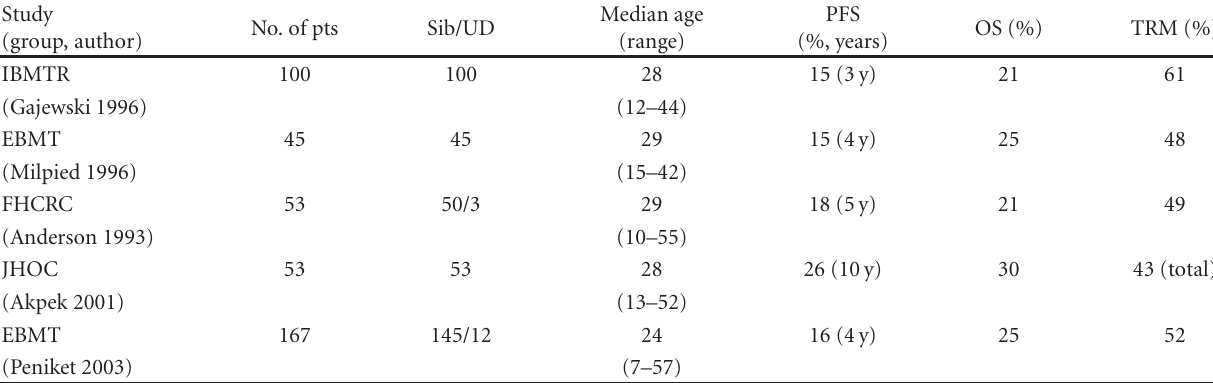
Table 8: Registry data of outcomes of myeloablative allogeneic transplants in relapsed and refractory Hodgkin’s lymphoma. Abbreviations: Sib/UD: Sibling/unrelated donor; PFS: progression-free survival; OS: overall survival; TRM: treatment-related mortality; IBMTR: International bone marrow transplant registry; EBMT: European Group for Blood and Marrow Transplantation; FHCRC: Fred Hutchinson Cancer Research Center; JHOC: Johns Hopkins Oncology